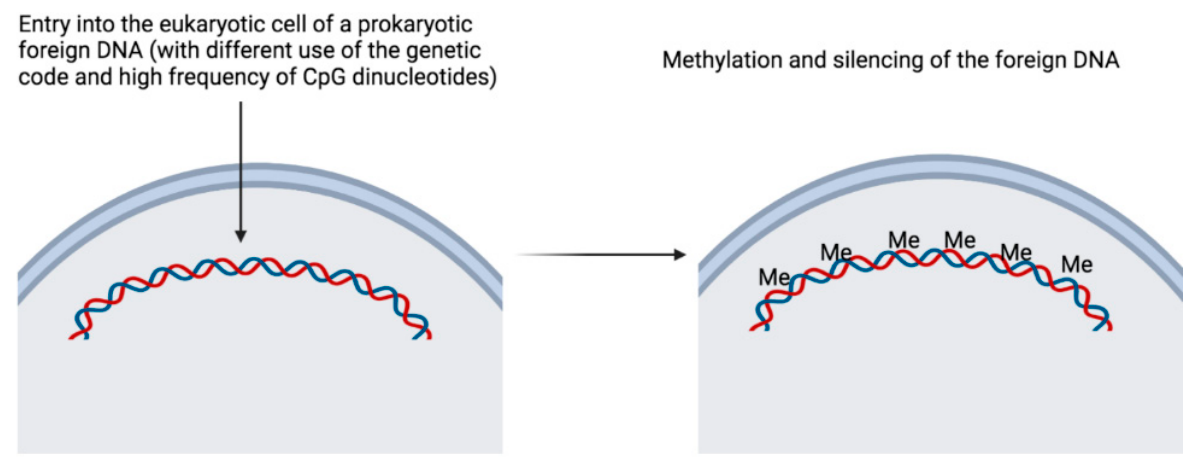
Figure 4. In a mouse oocyte, a foreign DNA (from a species far enough in the tree of life) is recognized as a foreign sequence because it contains an abnormally high number of CpG sequences and the preferential use of the genetic code is not the same. This leads to epigenetic silencing via methylation of the DNA during early development. This figure was created using BioRender (https://biorender.com/, accessed on 1 July 2022).